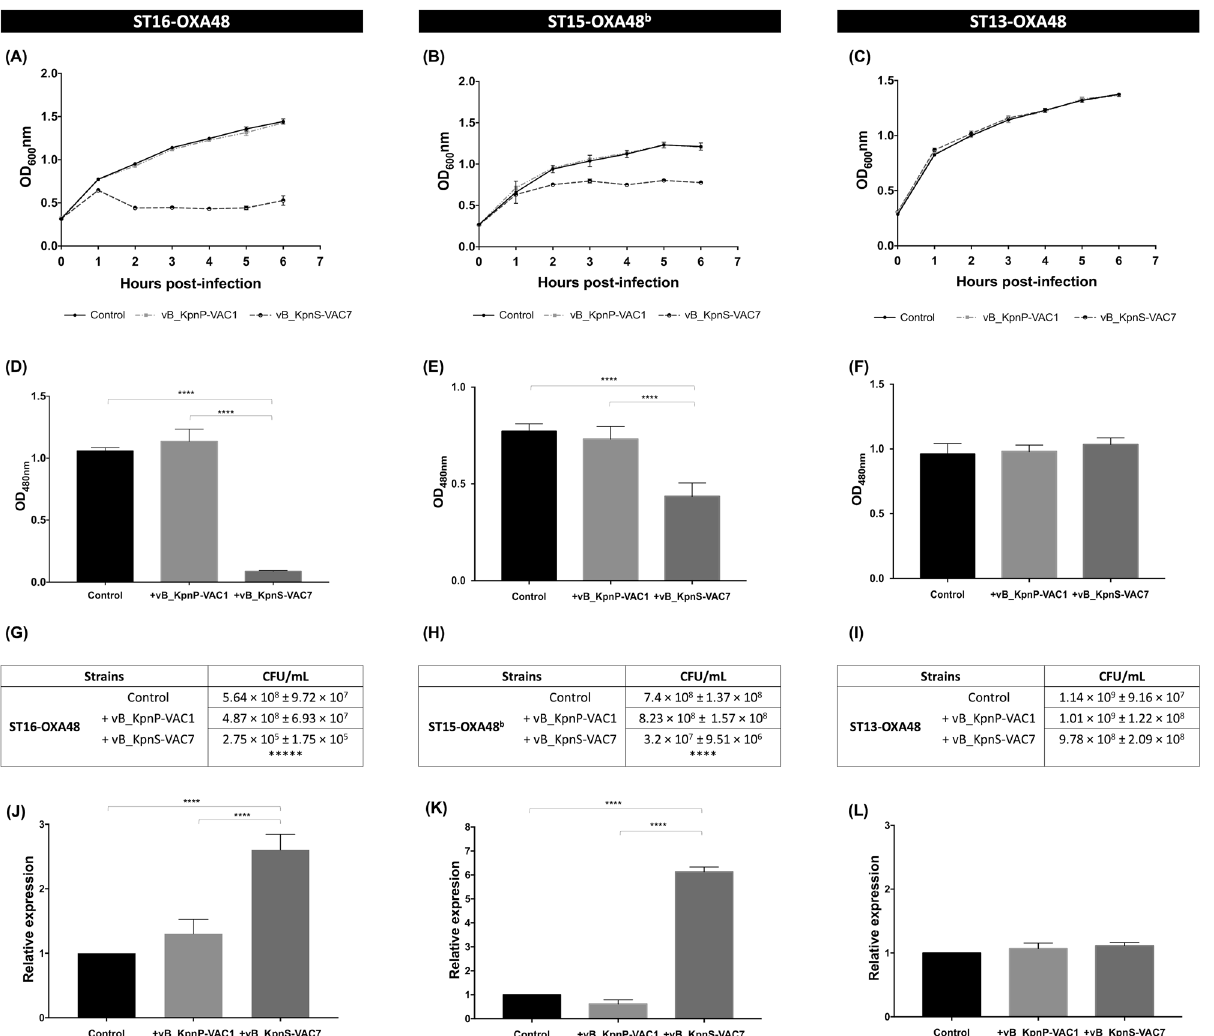
Figure 3. ( A–C ) Infection curves for the strains ST16-OXA48, ST15-OXA48 b and ST13-OXA48 with phages vB_KpnP-VAC1 and vB_KpnS-VAC7 at an MOI of 0.1. (D – F) . Measurement of metabolic activity of strains ST16-OXA48, ST15-OXA48 b and ST13-OXA48 by the colorimetric assay (WST-1 based) after 2 h of infection with phages vB_KpnP-VAC1 and vB_KpnS-VAC7 at an MOI of 0.1. (G – I) Measurement of viability by CFU/ mL counts of strains ST16-OXA48, ST15-OXA48 b and ST13-OXA48 after 2 h of infection with phage vB_KpnP- VAC1 and vB_KpnS-VAC7. (J – L) Measurement of the relative expression of the toxin pemK with respect to the antitoxin pemI in the clinical strains ST16-OXA48, ST15-OXA48 b and ST13-OXA48 by qRT-PCR after 30 min of phage infection with vB_KpnP-VAC1 and vB_KpnS-VAC7 at an MOI of 0.1. In all cases, the strain without phage infection was the control, and the errors bars represent the standard deviation of the three experimental replicates. In both the metabolic activity, viability and relative expression assays, strains ST16-OXA48 and ST15- OXA48 b show significant differences between the strains infected with phage vB_KpnS-VAC7 and the other two strains (****p-value < 0.001), while no significant differences were observed between the control and the strain infected with phage vB_KpnP-VAC1 (p-value > 0.05). However, in the case of the ST13-OXA48 strain, no significant differences were observed between the different strains (p-value >